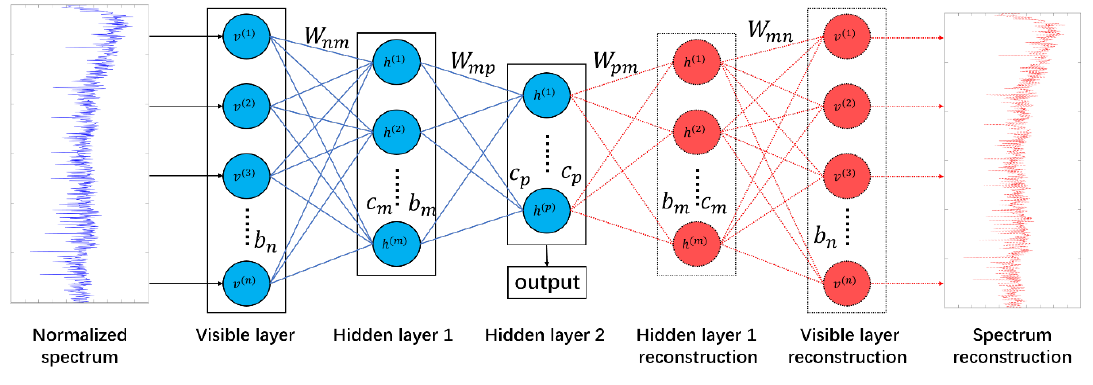
Figure 7. RBM auto-encoder structure.